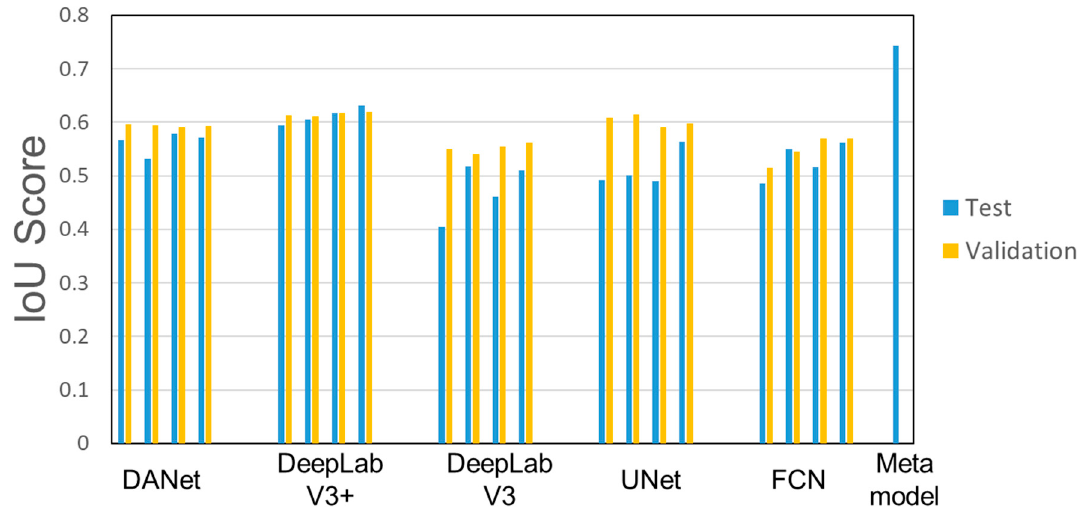
Figure 13. Comparison of IoU scores with segmentation models.